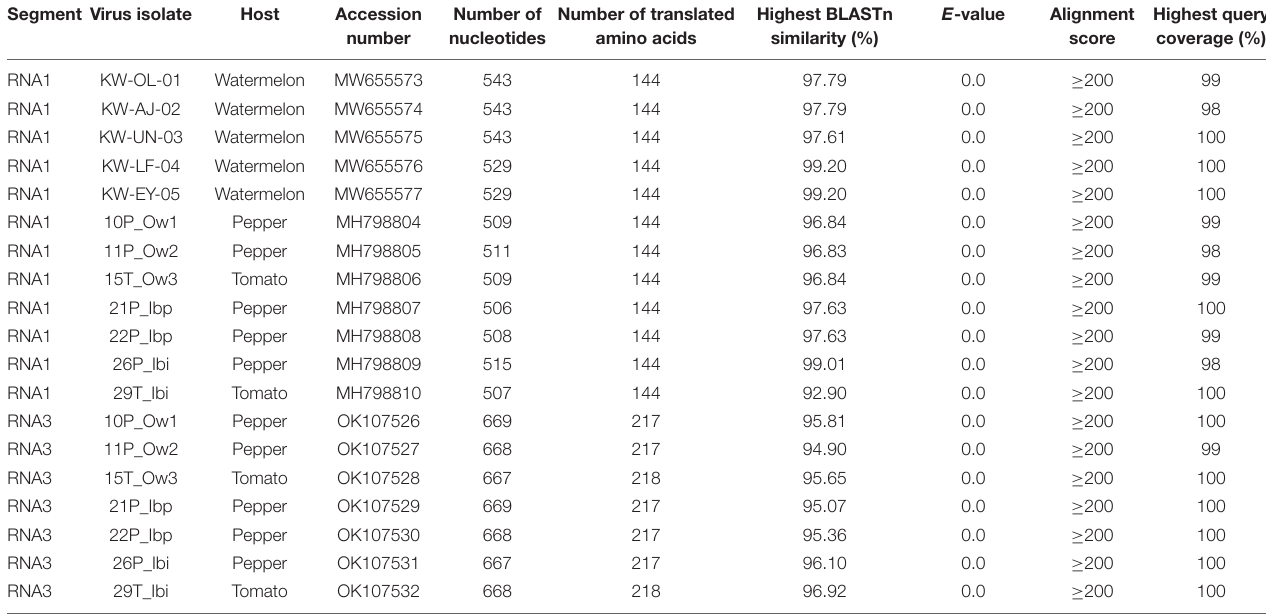
TABLE 2 | Summary of partial RNA1 and RNA3 sequence characteristics and BLASTn results obtained from CMV isolates in this study. Segment Virus isolate Number of